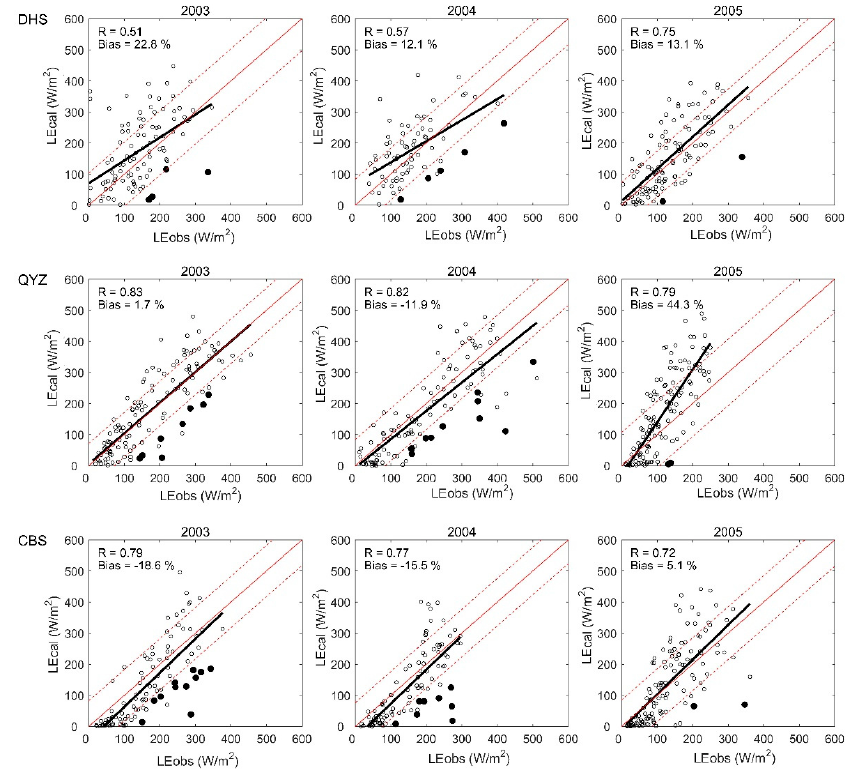
Figure 7. Comparisons between daily LE obs and LE cal at three sites from 2003 to 2005. The two dashed lines are the 1:1 line ± RMSE. Solid circles are samples severely contaminated by precipitation.